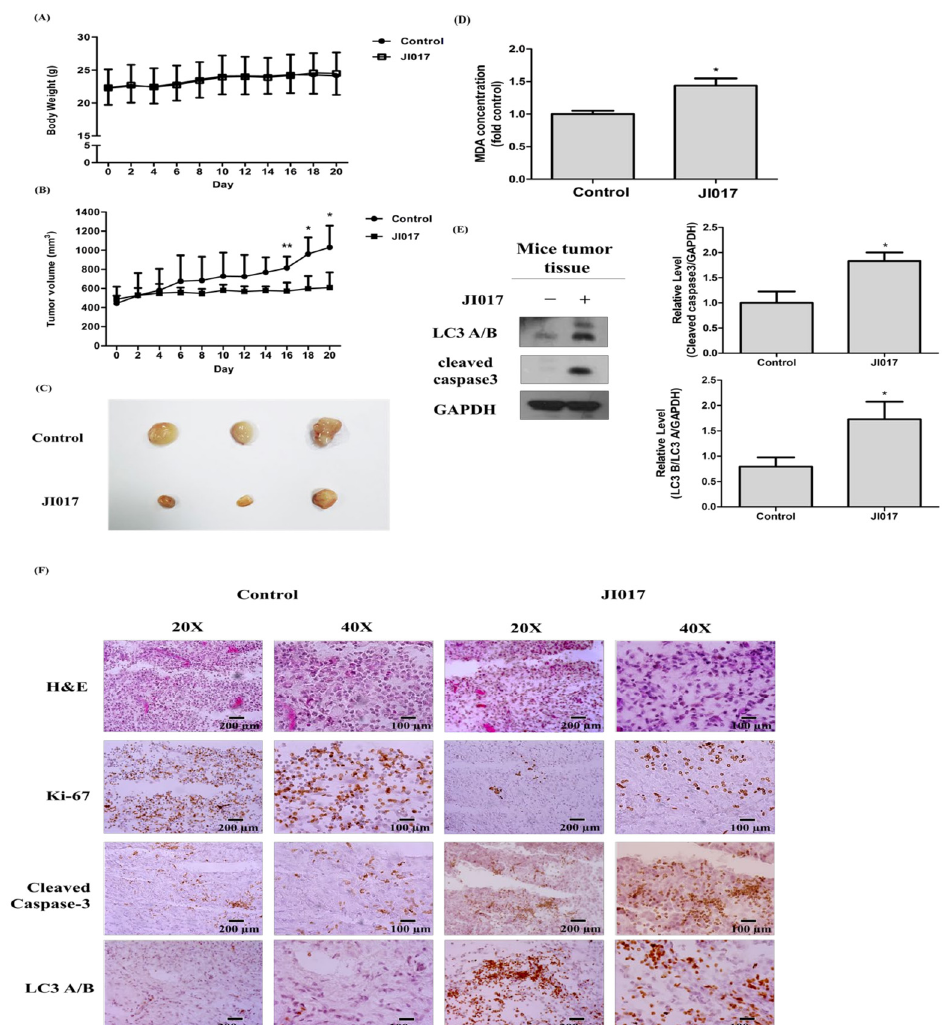
Figure 5. JI017 suppressed lung cancer cell growth in mice. BALB/c nude mice were subcutaneously injected with H460 cells. ( A ) The mouse body weight and ( B ) the tumor growth rate are shown. ( C ) Representative tumor images of the control group and the JI017-treated group. ( D ) The MDA concentration was assessed by a thiobarbituric reactive substance (TBARS) assay and normalized to the protein concentration. ( E ) Whole tissue lysates were analyzed by Western blotting with anti-LC3, anti-cleaved caspase 3, and anti-GAPDH antibodies. ( F ) The IHC staining of Ki-67 and cleaved caspase-3 and LC3 was carried out. Scale bar = 200 µ m for 20 × and Scale bar = 100 µ m for 40 × . The data are expressed as the mean ± SEM in all groups ( n = 8–11). * p < 0.05 and ** p < 0.01 compared to the untreated